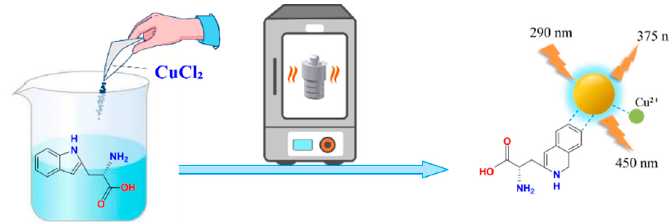
Figure 1. Synthesis route of Cu-CDs.